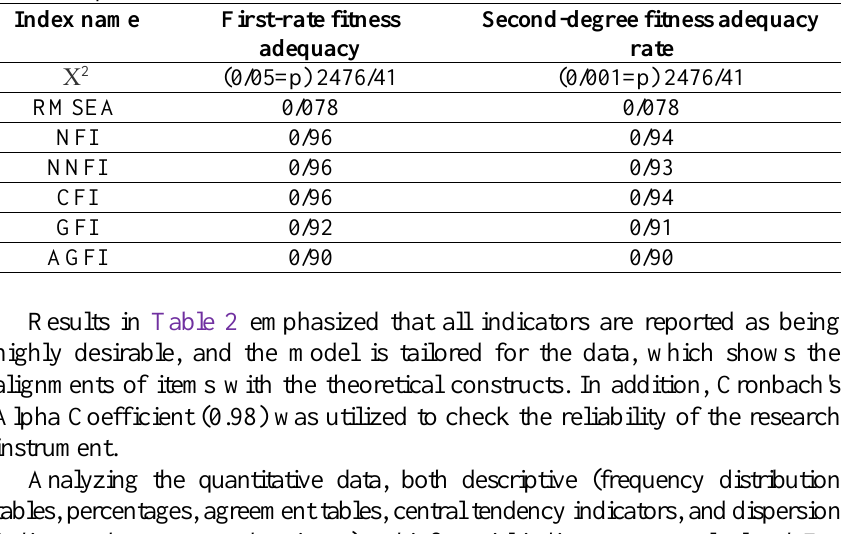
Confirmation indicators of first and second order confirmatory factor analysis of student